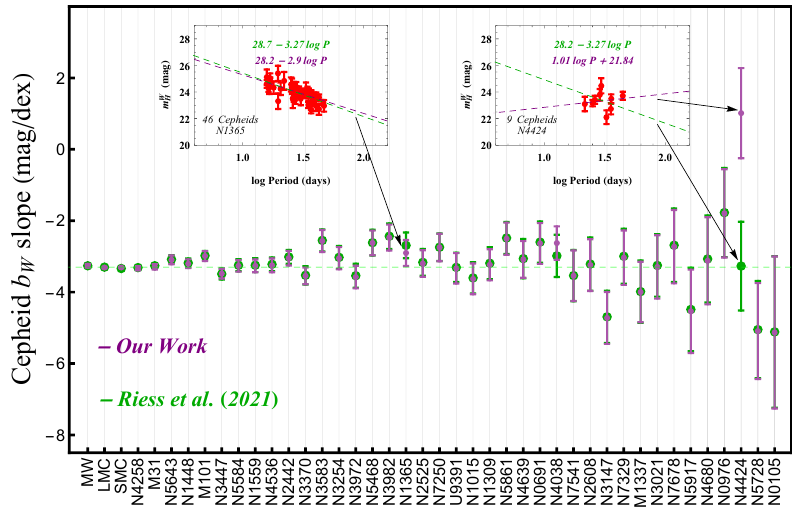
Figure A4. Independently-fitted slopes b W of the m W P-L relations (without background covariance H of any pair of Cepheids as was done in R21, i.e., taking into account only diagonal terms of the covariance matrix). The points in green are the corresponding points shown in Figure 10 of R21 (obtained using plot digitizer). Our fits are in excellent agreement with R21, with the exception of 3 points corresponding to hosts N4424, N4038 and N1365. For N4424, there is no point shown in Figure − log P plot of R21 (their Figure 9, where the magnitudes 10 of R21 but in the corresponding m W H decrease upward on the vertical axis), the indicated best-fit line is the green line shown in the upper right inset plot corresponding to the green point. The correct best-fit, however, corresponds to the purple line of the upper right inset plot with slope given by the purple point pointed by the arrow. Similarly, the best-fit line corresponding to N1365 shown in the upper left inset plot is identical to our purple point and not to the green point. For the Milky Way (MW), we used directly the values provided in R21 obtained from Gaia EDR3+HST.